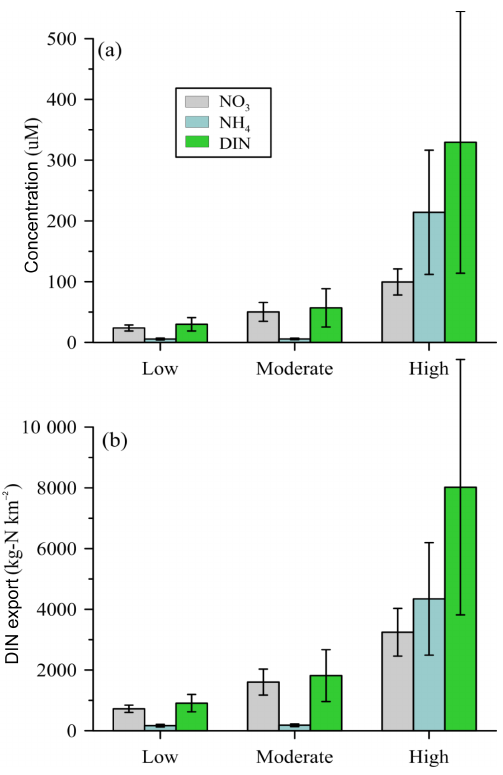
Figure 3. Mean riverine DIN concentration (a) and annual export (b) of the low, moderately, and highly disturbed watersheds during 2002–2012. The gray, sky blue, and green bars represent the NO 3 , NH 4 , and DIN of the three classes. Standard deviation for each bar is given as well.